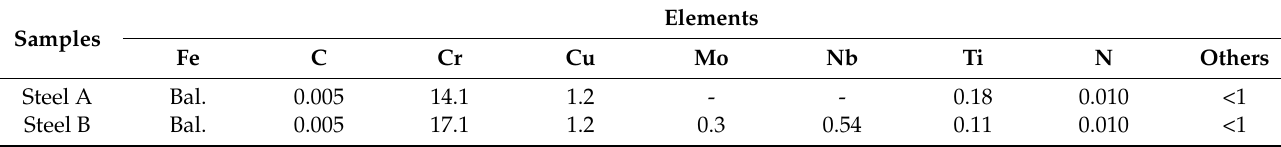
Table 1. Nominal composition (wt.%) of Steel A and Steel B